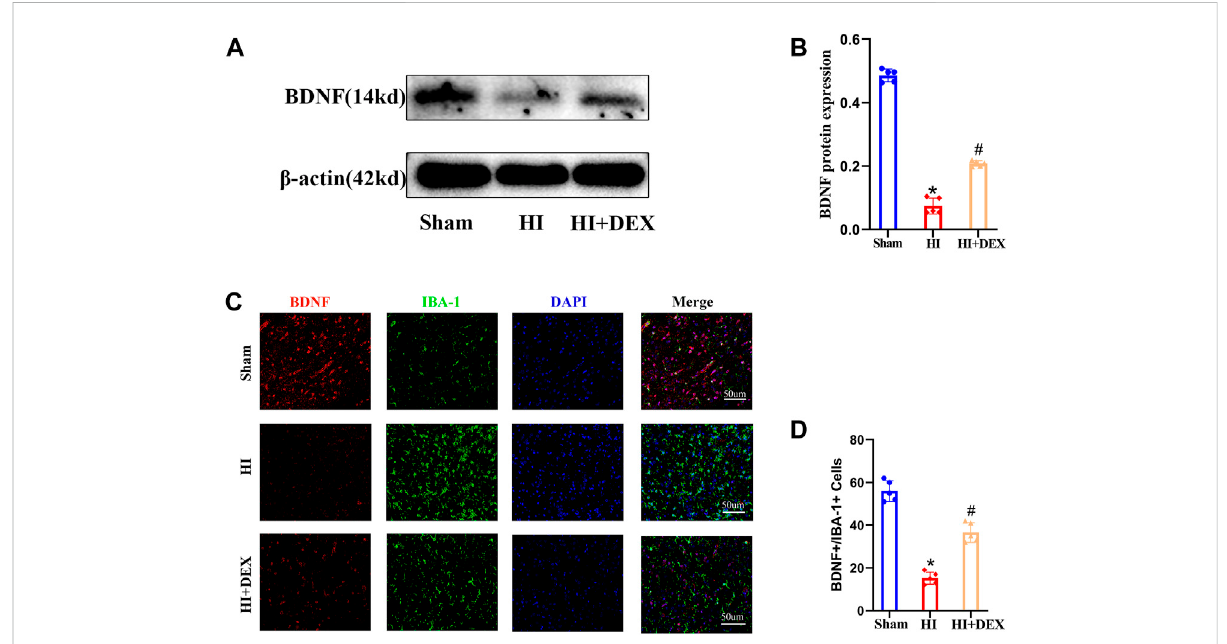
FIGURE 4 DEX enhanced the expression of BDNF in the ipsilateral injured hemisphere of neonatal rats with HIBD. Representative western blot image and quantitative analysis of the western blot (bar chart) illustrating the expression levels of BDNF in the ipsilateral injured hemisphere on D2 (A,B) . Representative IF image (magni fi cation ×400, scale bar: 50 μ m) and semi-quantitative analysis of the number of double-positive cells (BDNF + and IBA + , a marker of microglia) showed that BDNF was expressed in the microglia and its expression on D2 (C,D) . IF image showing that BDNF was expressed in the microglia. Western blotting and IF results also showed that HIBD induced a reduction in BDNF expression and the activation of microglia; this phenomenon was partially reversed by DEX. DEX, Dexmedetomidine; BDNF, Brain derived neurotrophic factor; HIBD, hypoxic- ischemicbraindamage;D2,2 daysafter HIBD;IF,Immuno fl uorescence.Thedataareexpressed asthemean±SD( n =5pergroup).* p < 0.05vs.the sham group; # p < 0.05 vs. the HI